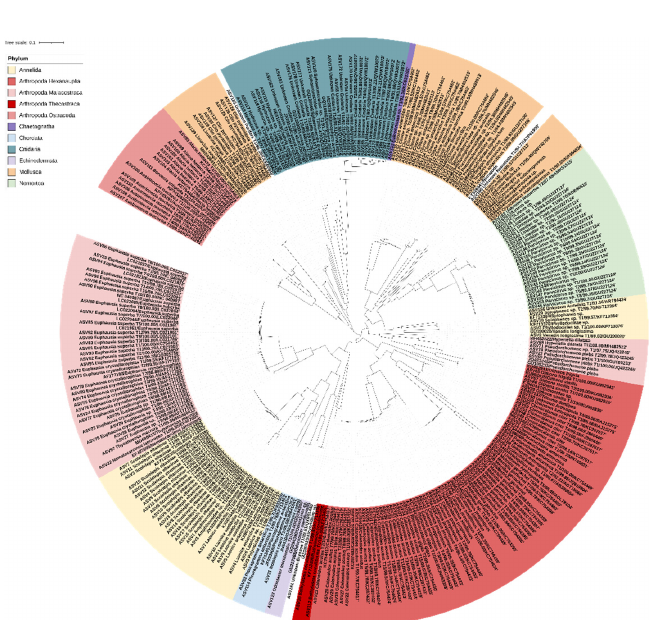
Figure 3. Maximum-likelihood (ML) phylogenetic tree of zooplankton haplotypes identified in the Ross Sea. The tree was constructed by Molecular Evolutionary Genetics Analysis (Mega) X software (v.10.0.5) with 1000 bootstrapping replications. In total, 55 and 183 haplotypes from RB and MB, respectively, and 75 reference sequences from the GenBank database were used for the analysis. As a result of the mini-read barcoding (MB), 2,640,586 and 788,096 raw reads were generated from the 14 libraries (6 in ANA08C and 8 in ANA09B, respectively) (Table 1). As a result of bioinformatic processes, including qualify filtering, merging, and chimera removal, a total of 1066 and 721 ASVs were identified from 1,268,522 (48.0%) and 360,336 reads (45.7%), respectively. After screening the artifacts using LULU curation, 206 and 122 ASVs were ultimately obtained (Table 1). Additionally, 60 non-metazoan ASVs were ex- cluded, and 154 and 103 metazoan ASVs were used for further analysis. Excluding 74 commonly identified ASVs, 183 ASVs were considered reliable putative haplotypes in the MB. They were classified into 26 species, 32 genera, 27 families, 17 orders, 11 classes, and 8 phyla (Tables 1 and S2). Although higher genus numbers were identified in 2018 (31 genera) than in 2019 (18 genera), proportions of 17 commonly identified genera were con- siderably high, accounting for 83.62% in 2018 and 84.65% in 2019 (Table 2). The most com- monly identified species was M . gerlachei (30.53% in 2018 and 16.50% in 2019), followed by Clione limacina antarctica (30.16% in 2018 and 12.65% in 2019) and C . acutus (2.66% in 2018 and 15.15% in 2019). Additionally, 14 genera were exclusively identified in 2018 (4.19%), whereas one species was identified only in 2019 ( P . antarctica, 0.74%). A total of 17 genera were commonly identified by both analyses; they accounted for 99.28% of RB and 82.14% of MB, indicating a high degree of taxon coverage of both primer sets (Table 3). Three RB-specific genera, including Nematocarcinus , Notolepis , and Cryocapu- lus , accounted for only 0.53% of total reads. Compared with those in RB, an 8.3-fold higher proportion of MB-specific genera was identified, accounting for 4.37% of total MB reads. Specifically, eight arthropod genera were exclusively identified in MB, including Calanus , Rhincalanus , Hyperiella , and Alacia (Table 3).